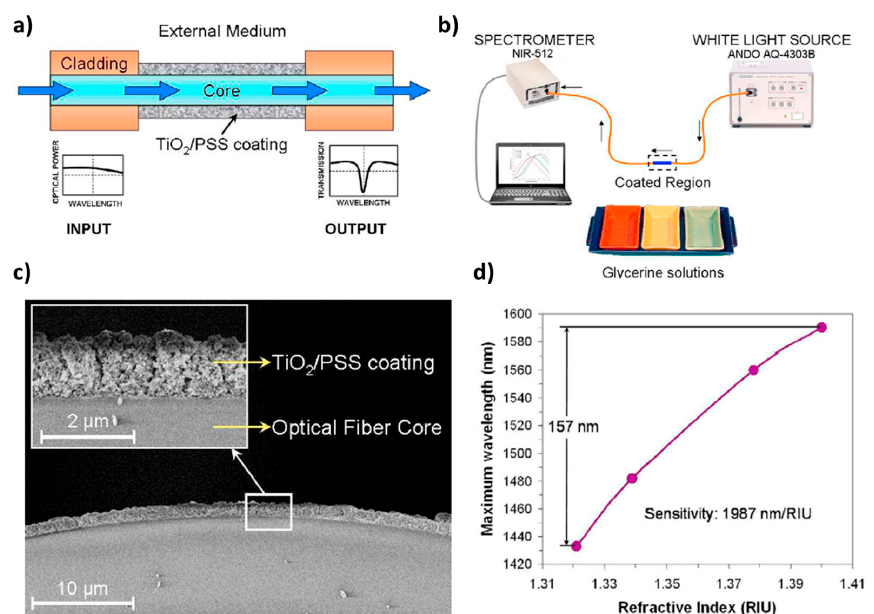
Figure 16. ( a ) Schematic representation of the optical fiber device; ( b ) Optical fiber transmission setup used to characterize the refractometer response; ( c ) SEM image and detail of the coated optical fiber core; ( d ) Variation of the maximum absorbance wavelength if the refractive index of the external medium is changed from 1.32 to 1.40. Reprinted with permission from Ref. [97].